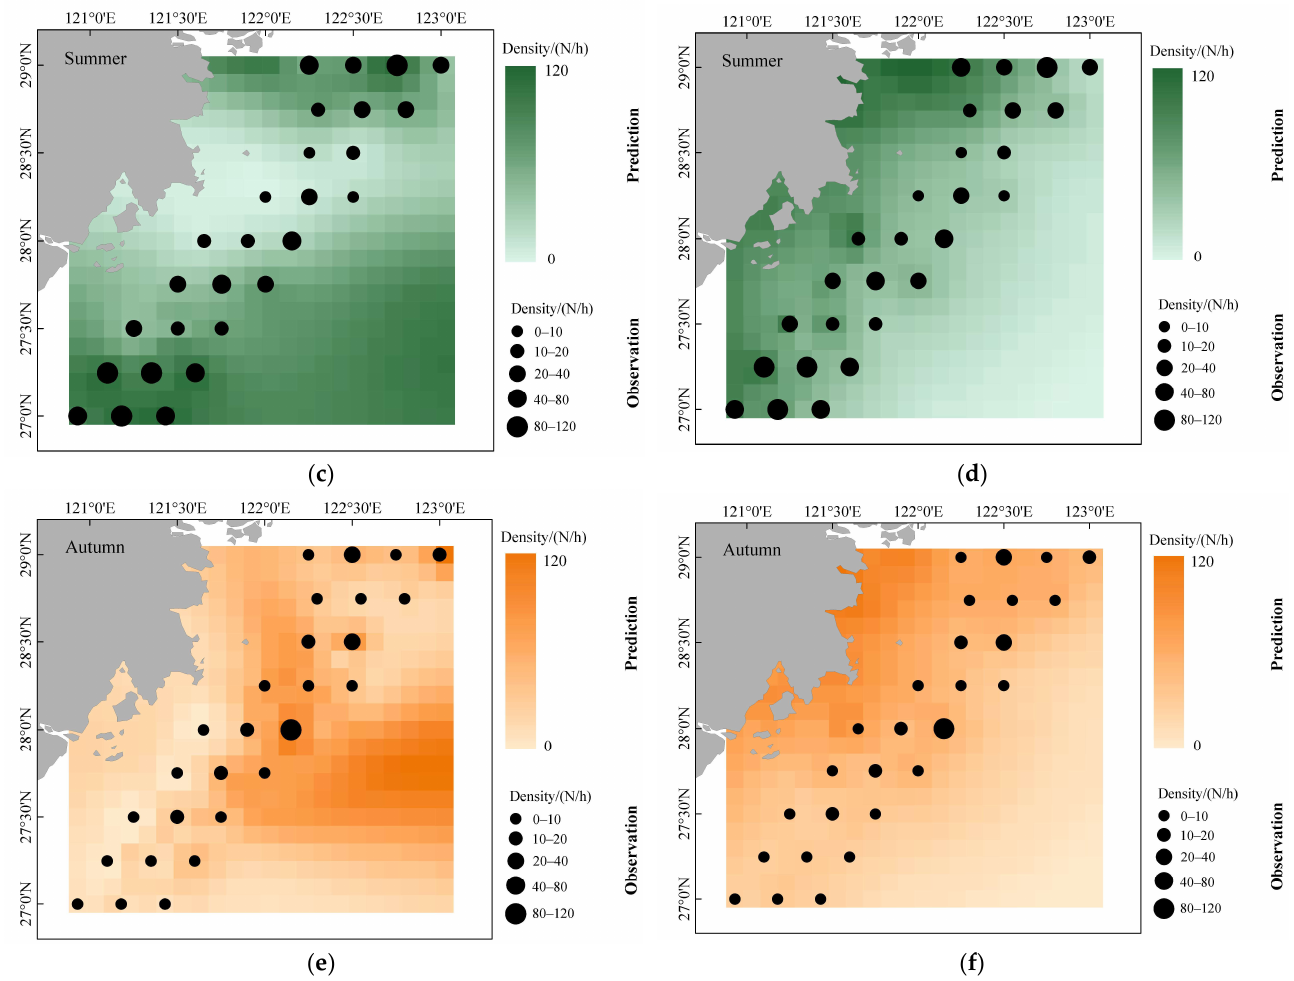
Figure 8. Predicted (color contours) and observed (black circles) distribution of D. maruadsi based on two GAMs. ( a ) Spring-GAM; ( b ) Yearly-GAM in Spring; ( c ) Summer-GAM; ( d ) Yearly-GAM in Summer; ( e ) Autumn-GAM and ( f ) Yearly-GAM in Autumn.